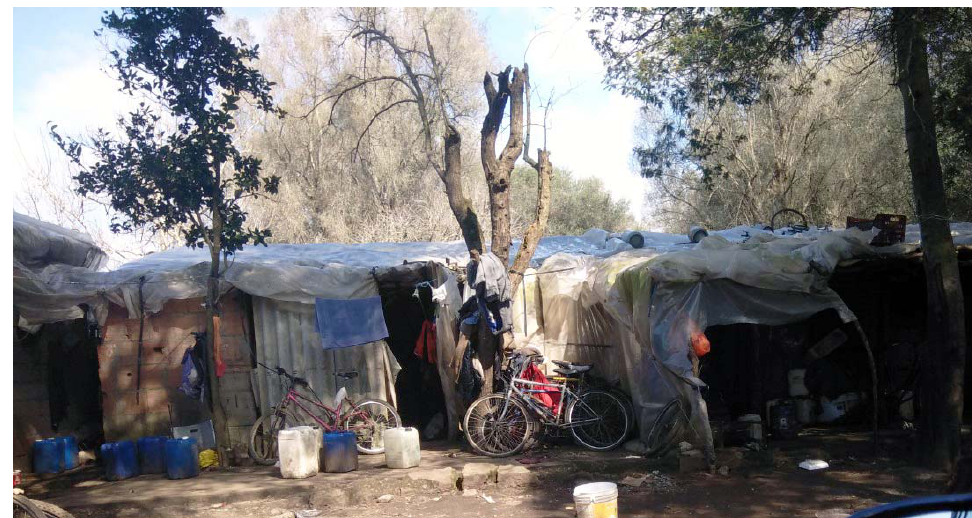
Figure 2. The exterior of makeshift shacks in the San Ferdinando settlement.